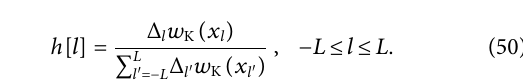
Frontiers in Signal Processing |